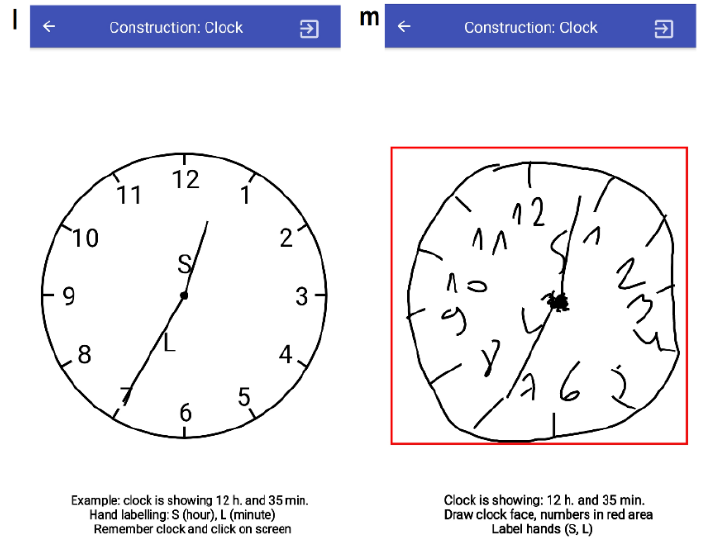
Figure 2. Screenshots of the task T10: clock construction (l — showing, m — constructing clock).